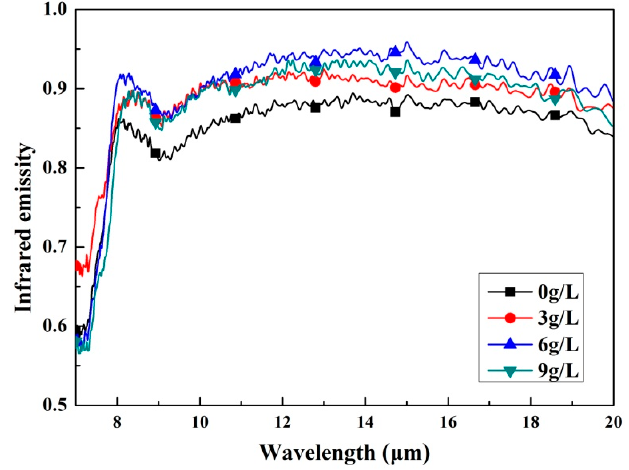
Figure 6. Infrared emissivity curves of the MAO coatings with different K 2 ZrO 4 concentrations within a waveband of 7–20 µm.